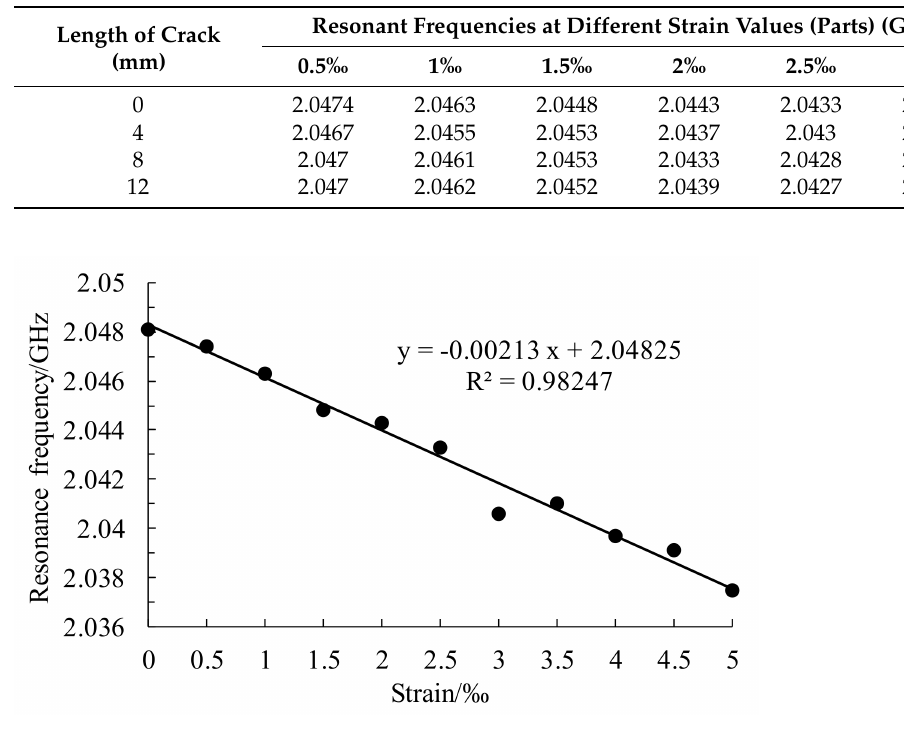
Figure 12. Variation in the resonant frequency of the upper patch with increasing strain (no